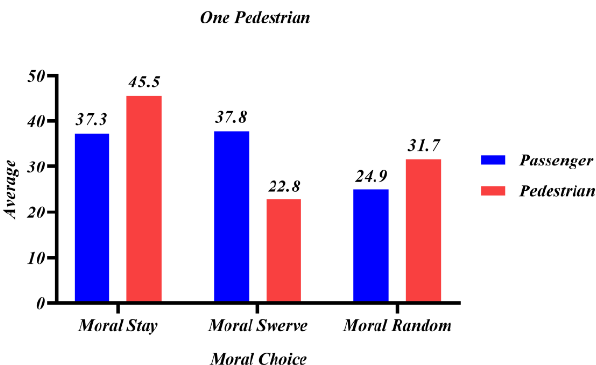
Figure 10. Mean values of participants’ evaluation scores for different moral choices when there was one sudden pedestrian intruder.